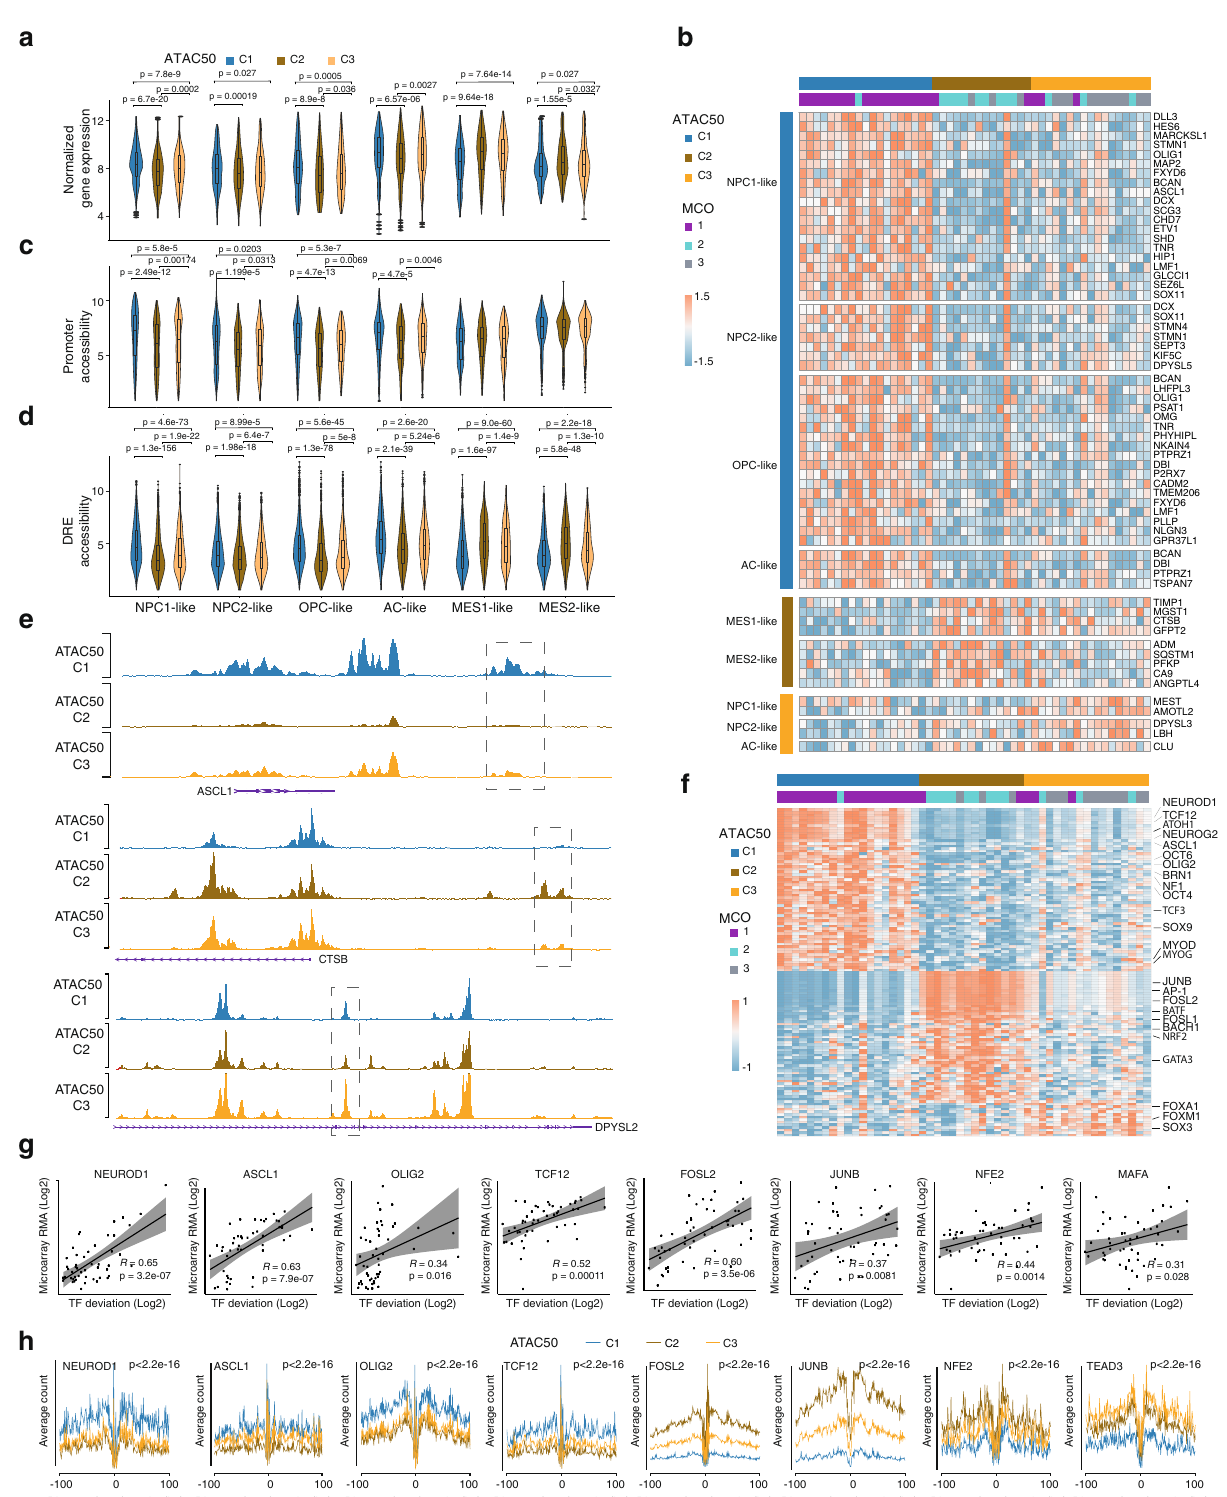
genes (Fig. 4b) between clusters (Supplementary Data 5) which showed that 47% (25 of 53) had signi fi cantly different chromatin accessibility in DRE regions (Fig. 4e and Supplementary Data 5), compared to only 7 of 53 for promoter regions, supporting the importance of DREs in regulating ATAC50